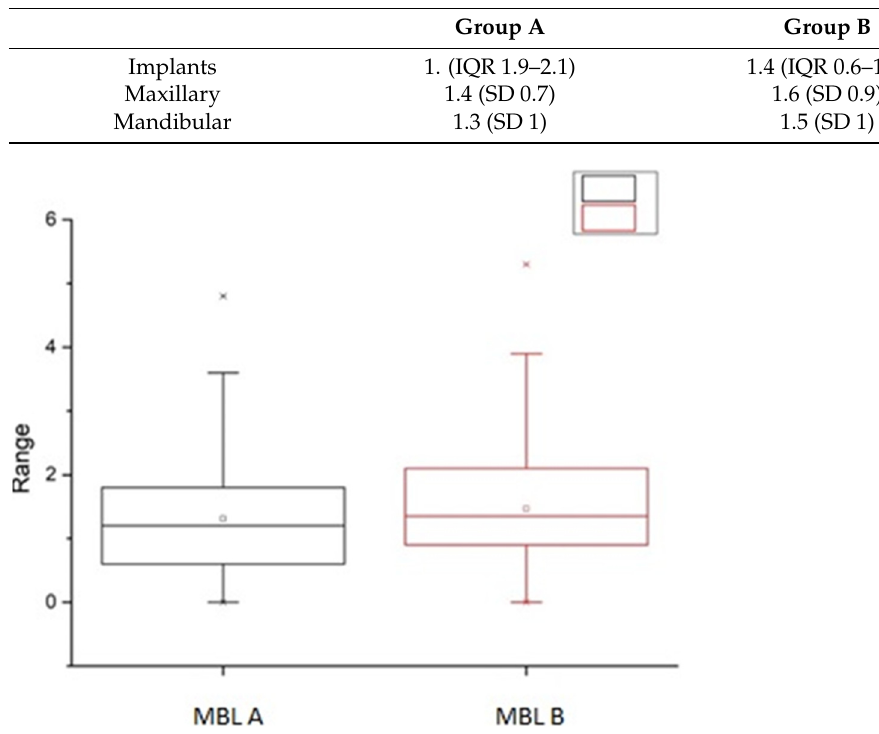
Figure 5. Mean MBL with IQR.